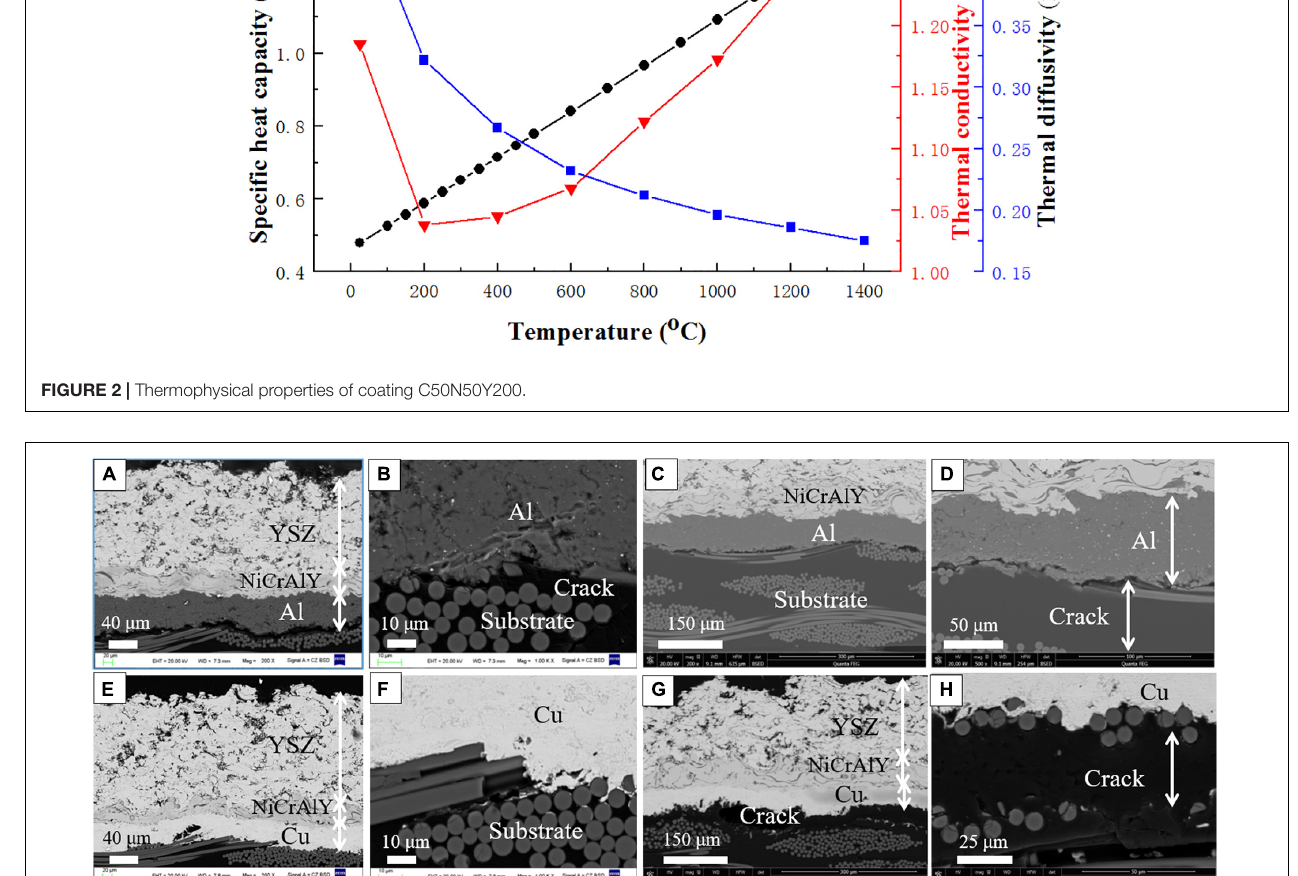
FIGURE 3 | SEM cross-section macrographs of different TBCs after deposition: (A,B) A50N50Y200; (E,F) C50N50Y200; SEM cross-section macrographs of different TBCs after thermal shocking at 230 ◦ C: (C,D) A50N50Y200 after 20 thermal shocks, (G,H) C50N50Y200 after 182 thermal